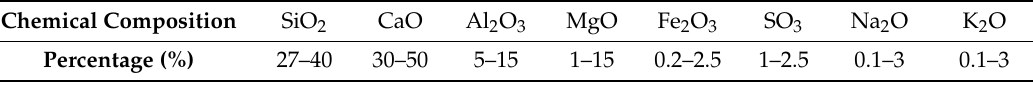
Table 1. Typical composition range of blast furnace slag